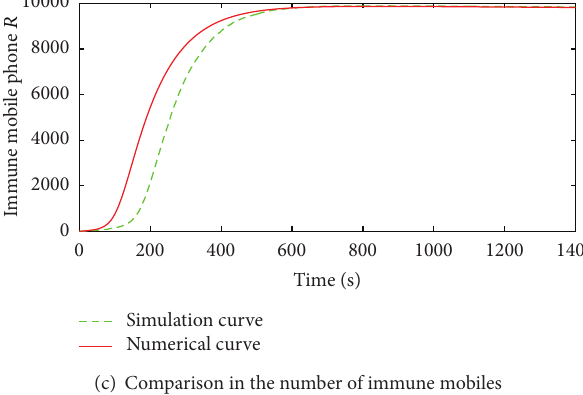
Figure 9: Comparisons between numerical and simulation results in the M-SIR model.